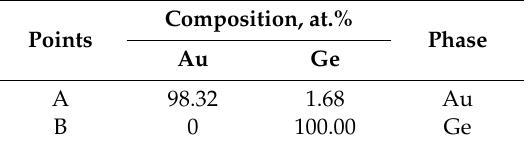
Table 1. The energy-dispersive spectrometer (EDS) results of Figure 5.